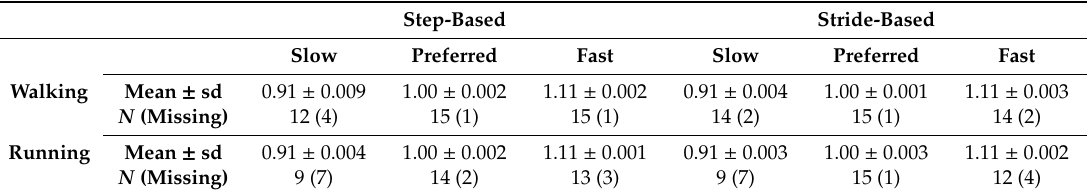
Table 2. Normalized cadence during stationary auditory-motor coordination (mean ± standard deviation (sd)) and the number of participants N who did (not) achieve